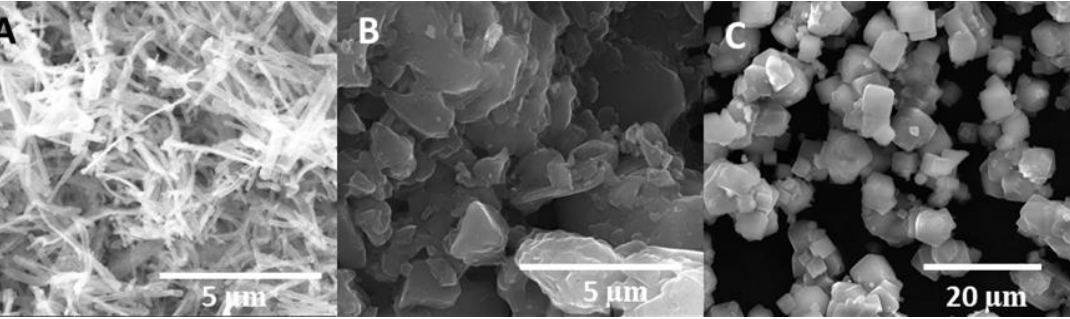
Figure 4. SEM images of the supports: ( A ) polypyrrole nanotubes; ( B ) activated carbon; ( C ) zeolite.